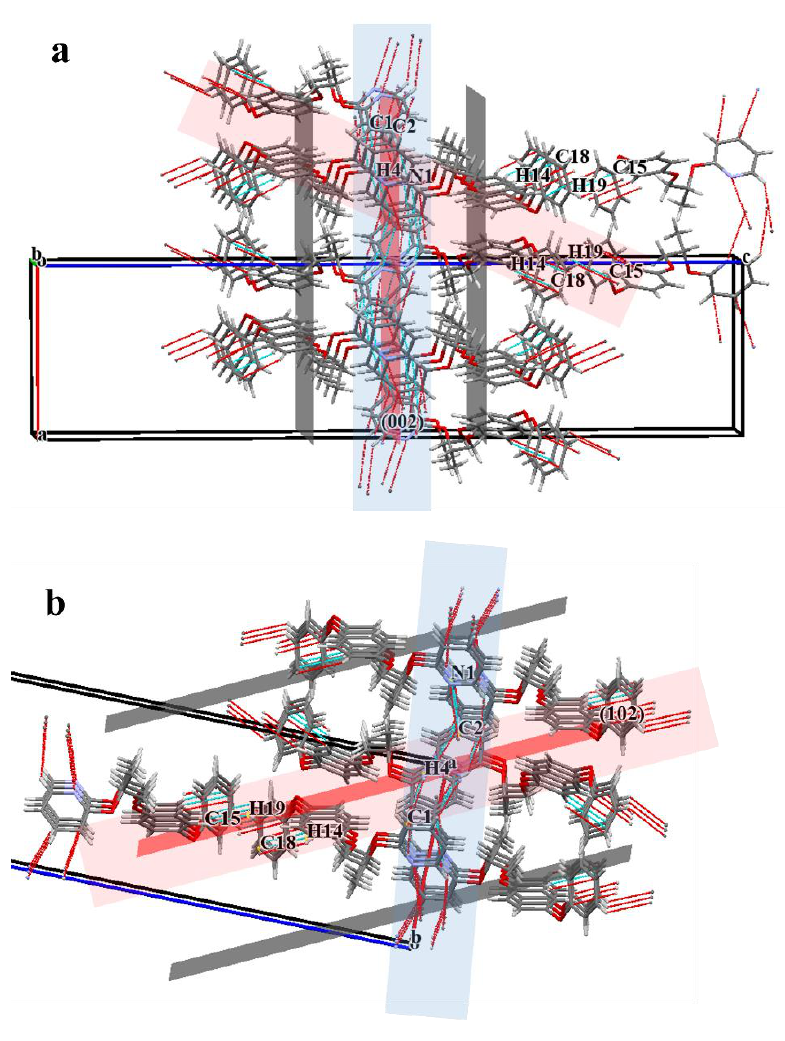
Figure 8. The bond chains (red and cyan short line) and crystal plane (red and gray plane) of pyriproxyfen crystal. ( a ) (002) face; ( b ) (102) face. The blue block is the bond chain composed of N1-C2 and C1-H4 bonds, and the red block is the bond chain composed of H14-C18 and H19-C15 bonds.